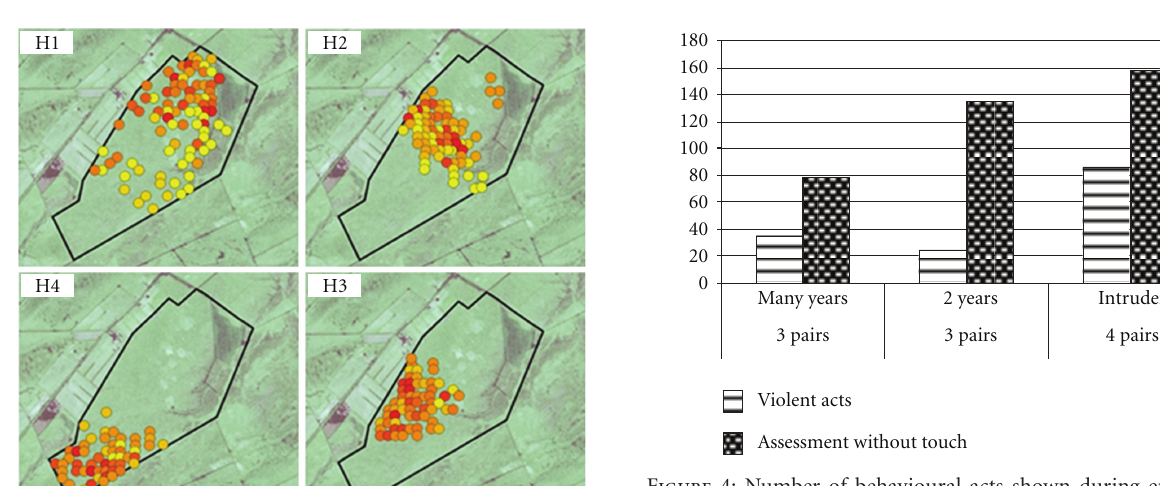
Figure 4: Number of behavioural acts shown during encounters between pairs of stallions that have shared the same pasture for di ff erent length of time, split into violent and nonviolent